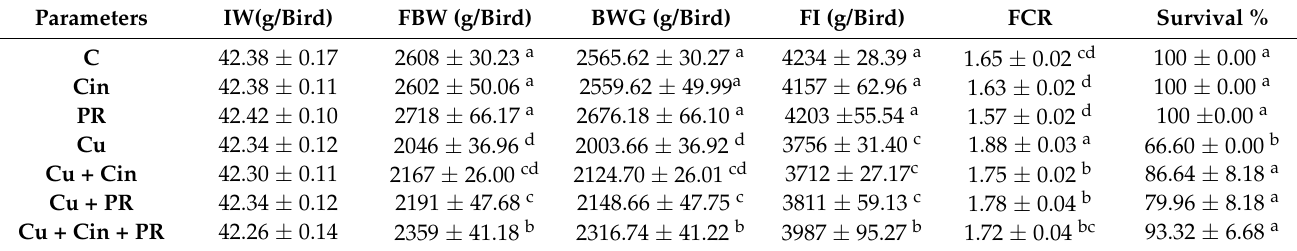
Table 5. Growth performance of broiler chickens treated with copper, cinnamon extract, and probiotic. Parameters